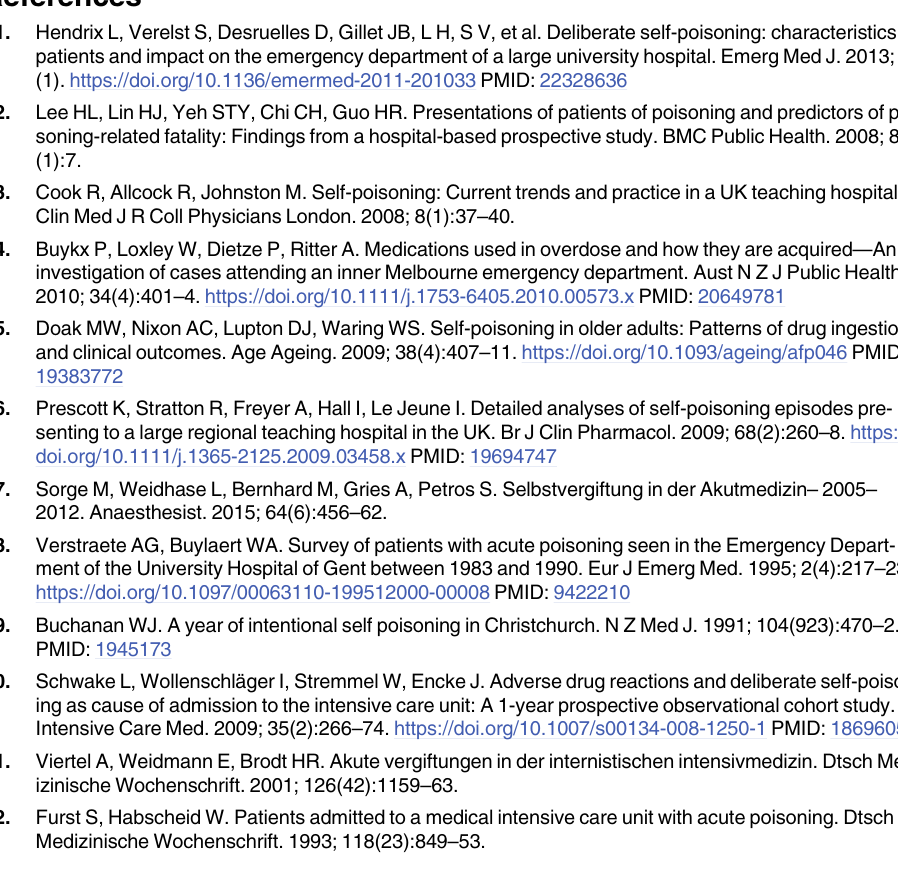
S4 Table. P-values of pairwise comparison between severity of poisoning and different patient characteristics listed in Tables 1–3. (TIF) S1 Fig. Age distribution within the severity levels grouped by gender.